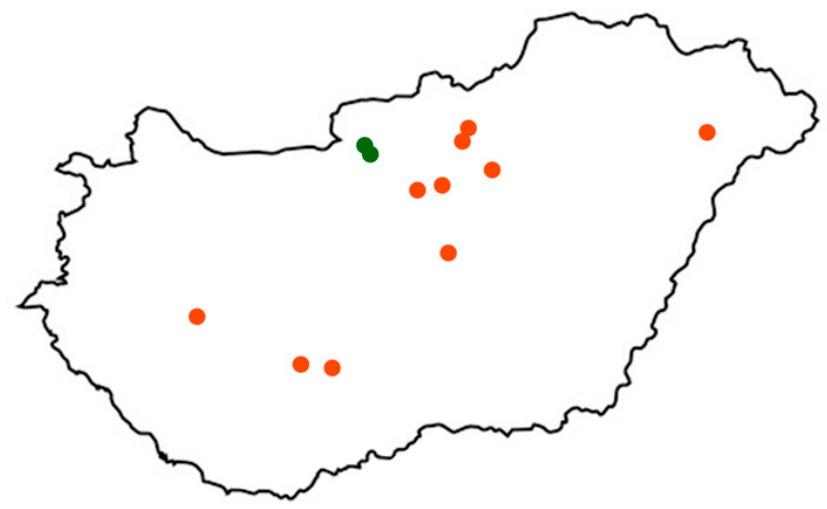
Figure 1. The places of origin of tomato gene bank accessions (red spots) and the locations of the experiment (green spots) in Hungary.